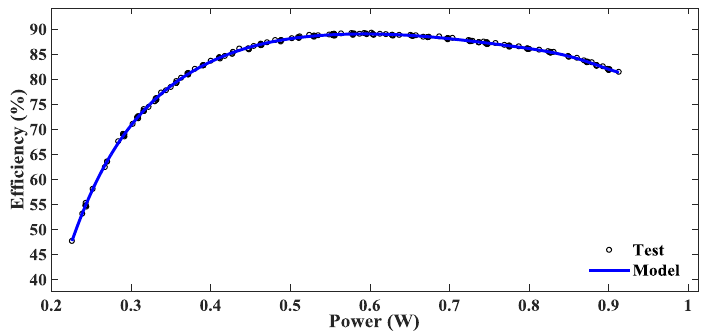
Figure 16. Measured efficiency η e as a function of power at L 0 / C 0 ≈ 10.